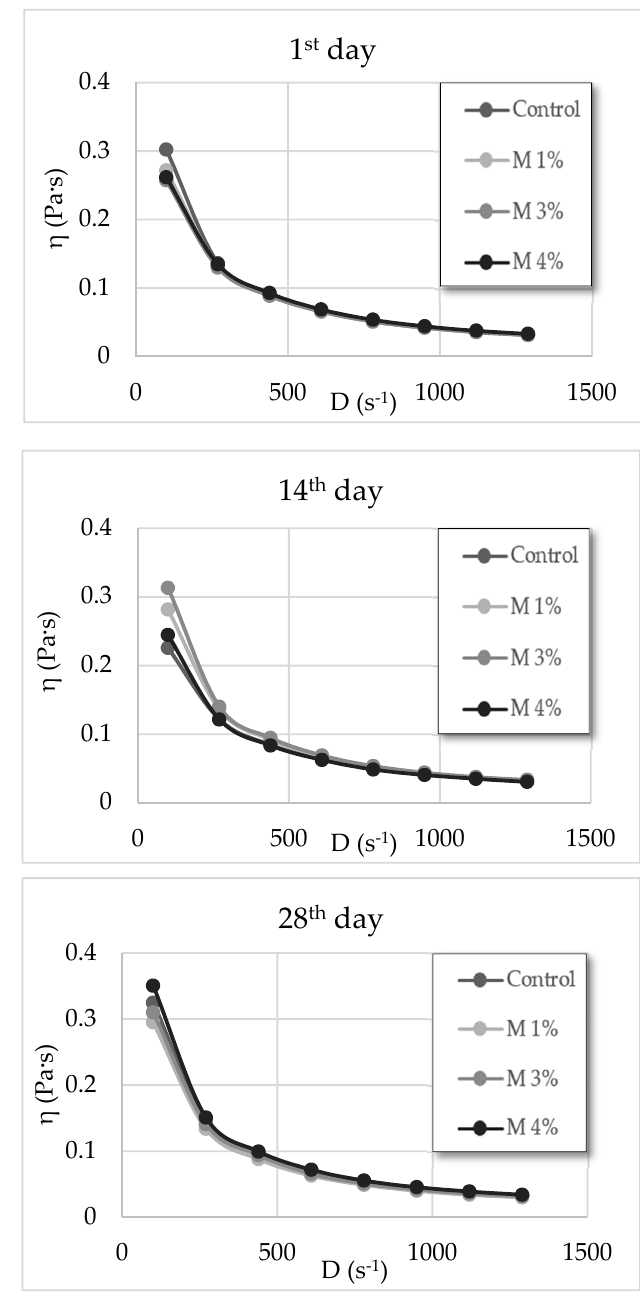
Figure 2. Changes in viscosity (µ, Pa s) of yoghurt samples without (Control) and with the addition